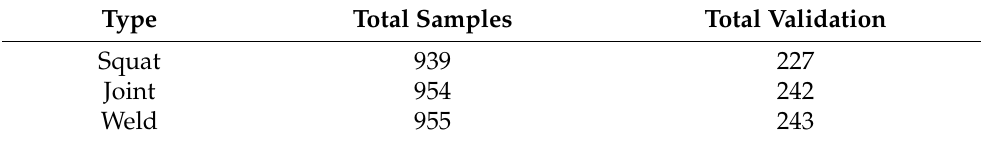
Table 1. Data set